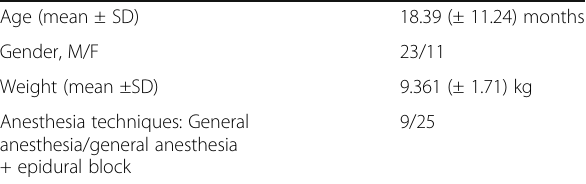
Table 1 Demography and anesthesia techniques